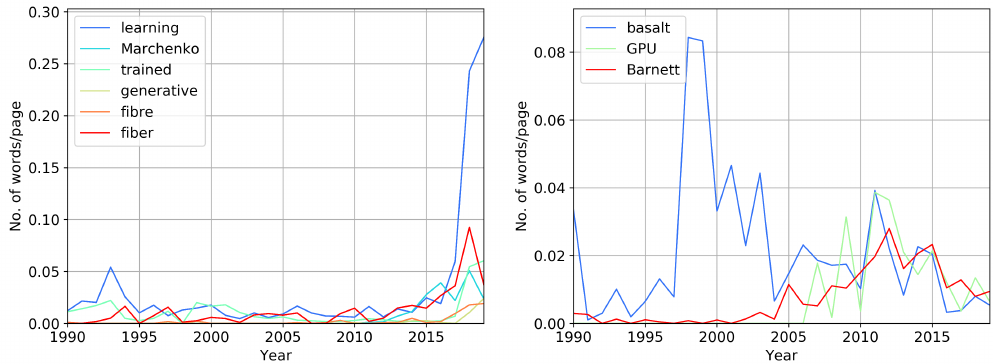
Figure 11. Words that show the highest rate of growth in occurrence ( left ) and decline ( right ) in the past four years.